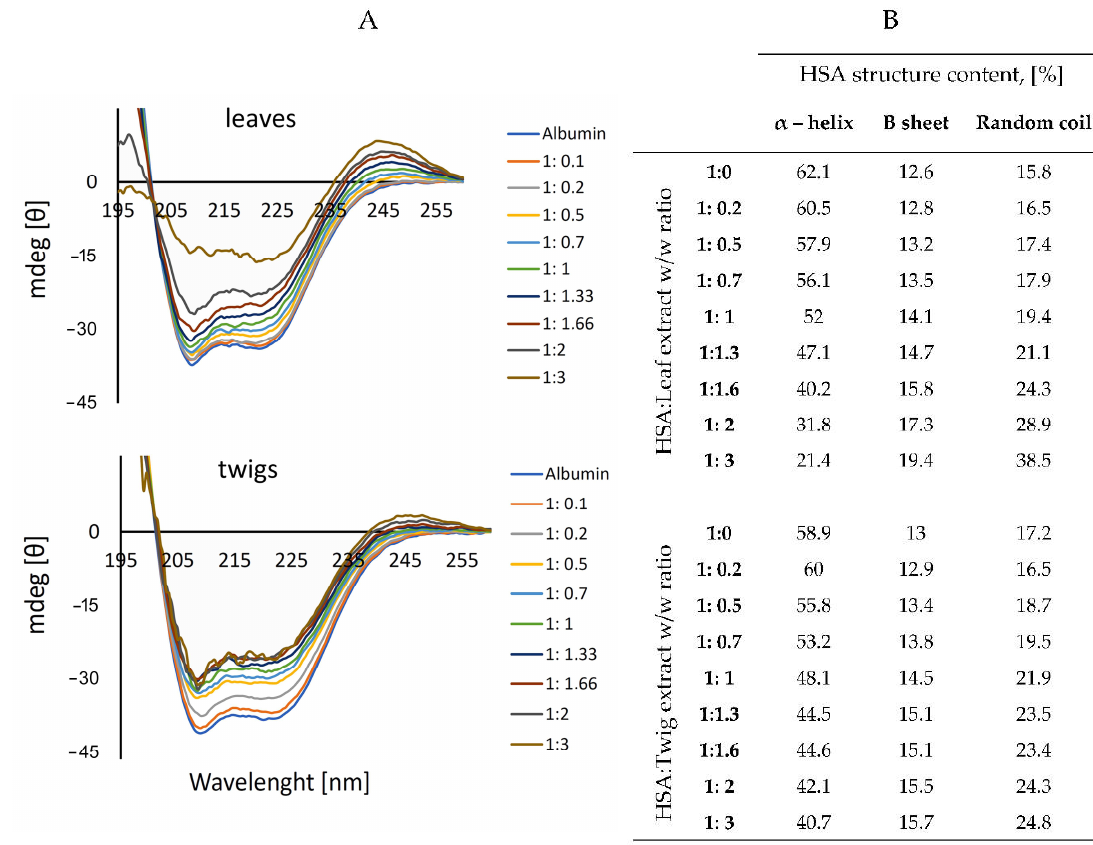
Figure 2. Ellipticity changes ( A ) and changes in the secondary structure ( B ) of human serum albumin at the concentration of 1 µmol/L in the presence of varying ratios (1:0.1–1:3) of leaf and twig extracts of R. canina .